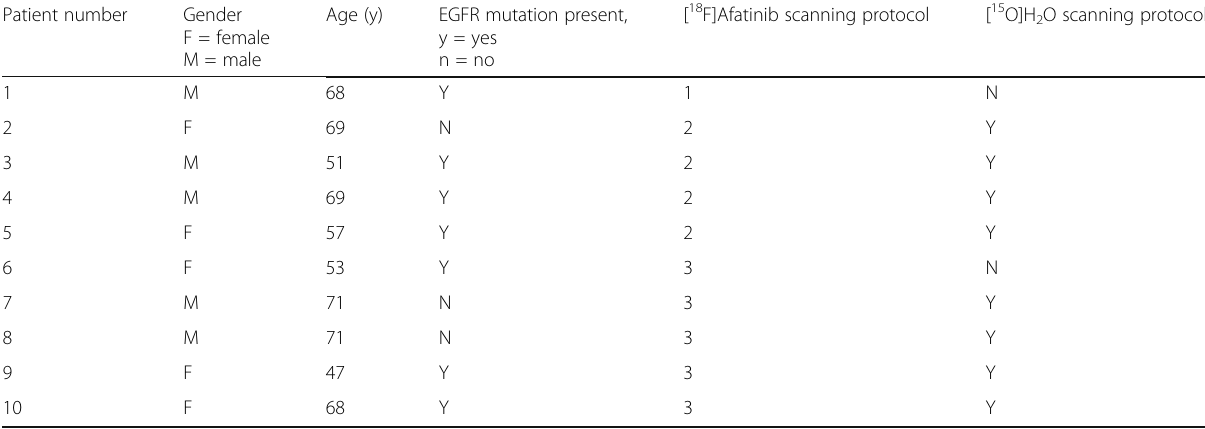
Table 1 Baseline and scanning characteristics Patient